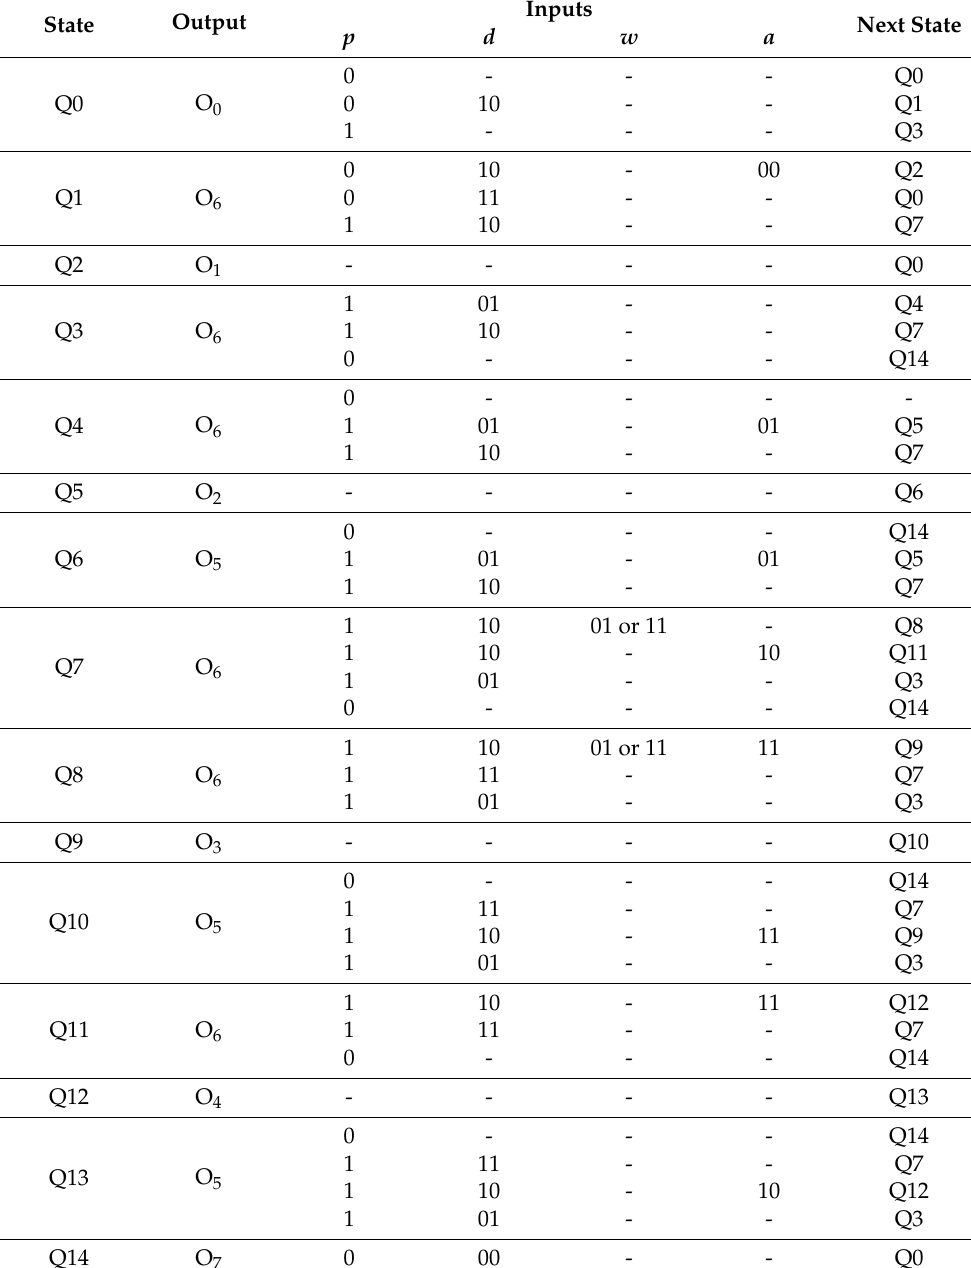
Table 4. Decision-making systems implemented as Moore finite-state